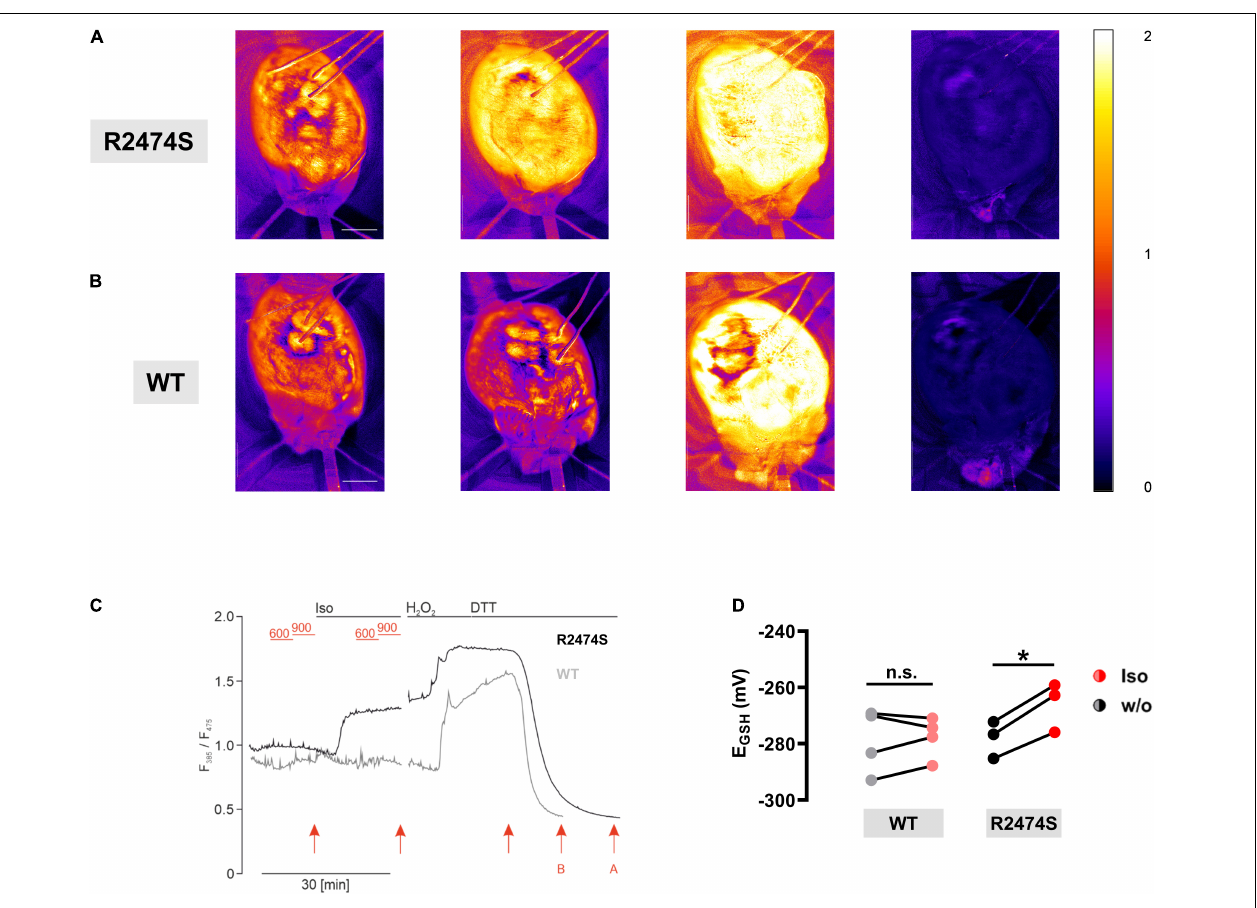
FIGURE 9 | β -adrenergic stimulation induces mitochondrial oxidation in intact RyR2-R2474S hearts. (A,B) Color-coded I385/I470 nm ratio comparing a representative RyR2-R2474S dTG-heart (A) and a RyR2-WT heart (B) . From left to right: (i) baseline control, (ii) following isoproterenol (33 nM) stimulation, (iii) treatment with H 2 O 2 (200 µ M) and iv) DTT (4 mM) (scale bar, 2.5 mm). (C) Representative time course of the normalized I385/I475 nm ratio comparing RyR2-WT and RyR2-R2474S dTG-hearts. Black lines indicate each perfusion with 33 nM isoproterenol, 200 µ M H 2 O 2 , and 4 mM DTT. The baseline heart rate for RyR2-WT and RyR2-R2474S was 340 bpm and 275 bpm, respectively. In-between, we performed electrical pacing with 600 bpm and 900 bpm (red lines). Red arrows refer to time points for representative images shown in (A,B) . (D) Paired dot-line plot showing E GSH calculated before and after application of isoproterenol each for RyR2-WT and RyR2-R2474S dTG-hearts. Each dot represents one heart/experiment. Paired Student’s t -test; * P = 0.013; n.s.,